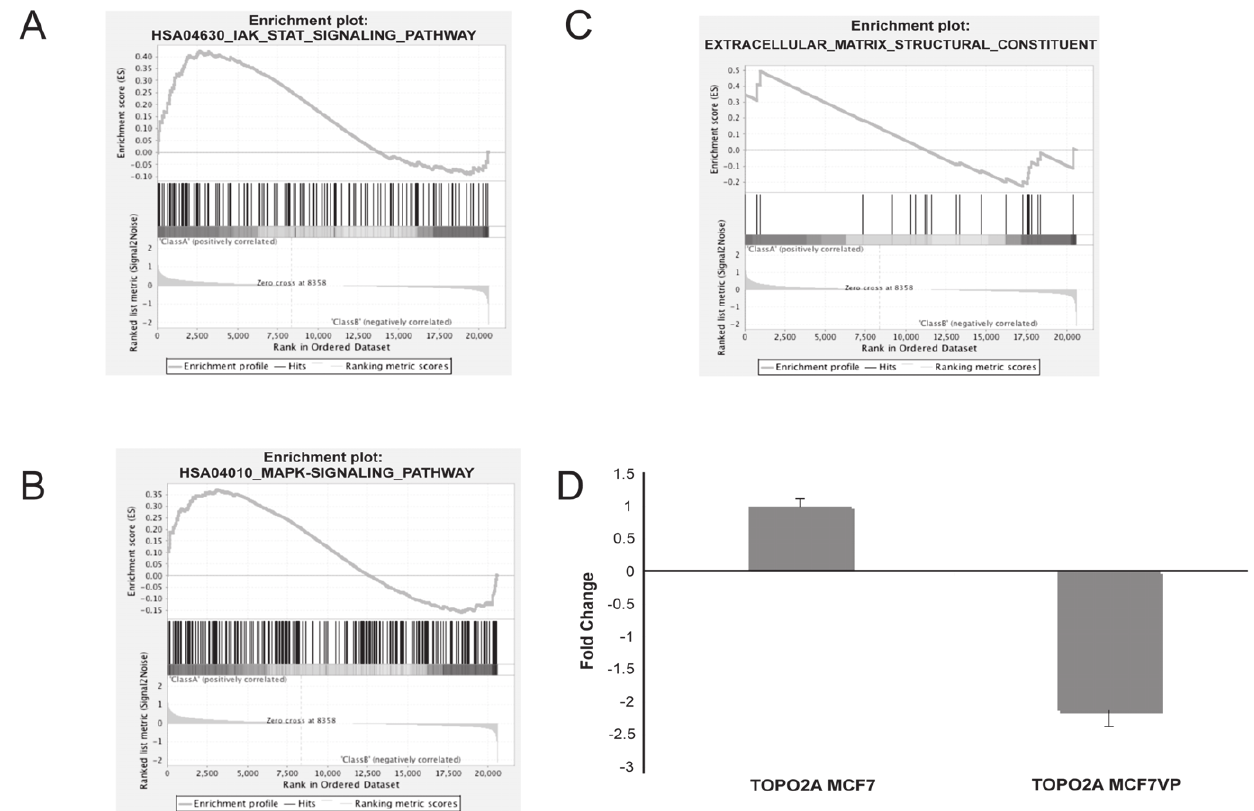
Figure 5. GSEA analysis of microarray data showing enrichment of the JAK-STAT and MAP Kinase pathways and upregulation of ECM structural component genes along with qRT-PCR validation of the down-regulation of topoisomerase 2 gene expression in MCF7VP cells. Fig. 5A. Gene set enrichment analysis of microrray data depicting the enrichment of genes in the JAK-STAT signaling pathway. The GSEA software was used to calculate the enrichment levels. Fig. 5B. Gene set enrichment analysis of microrray data depicting the enrichment of genes in the MAP kinase signaling pathway. The GSEA software was used to calculate the enrichment levels. Figure 5C. Gene set enrichment analysis depicting enrichment of ECM (extra-cellular matrix) genes in MCF7VP cells. The GSEA algorithm was used to calculate the enrichment levels. Figure 5D. Down-regulation of TOPO2A (the drug target of etoposide) in MCF7VP cells. The microarray data was validated by qRTPCR as depicted in the bar chart which shows differences in fold